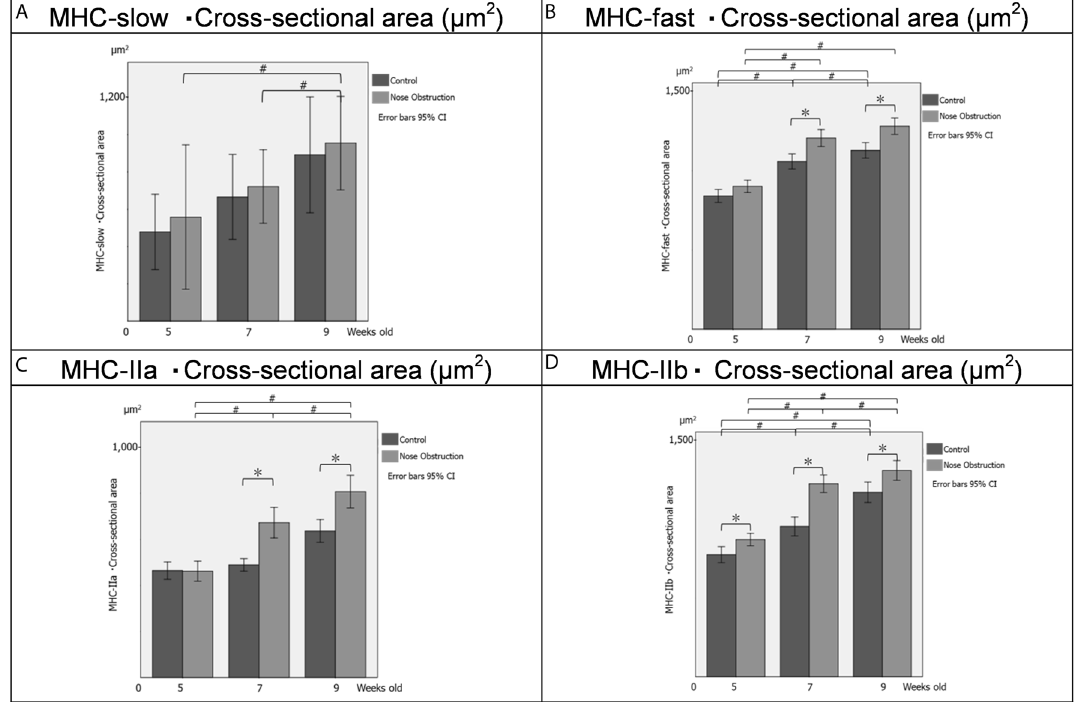
Figure 4. Cross-sectional area of the genioglossus muscle fibers. ( A ) Cross-sectional area of the slow-type muscle fibers at 5, 7 and 9 weeks old. ( B ) Cross-sectional area of the fast-type muscle fibers at 5, 7 and 9 weeks old. ( C ) Cross-sectional area of the fast IIa-type muscle fibers at 5, 7 and 9 weeks old. ( D ) Cross-sectional area of the fast IIb-type muscle fibers at 5, 7 and 9 weeks old. Bars in black, Control group; bars in grey, nose obstruction group. The x-axis shows the age of the rats, the y-axis shows the cross-sectional measurement of muscle fibers, for both control and nose obstruction groups. A repeated-measures multivariate analysis of variance was performed for intergroup and intragroup statistical comparisons. A simple main-effects analysis with Sidak adjustment was performed for multiple comparisons. Data are expressed as mean ± standard deviation. * ,# P < 0.05. Error bars at 95% confidence interval. MHC-slow Myosin heavy chain expression of slow- type muscle fiber, MHC-fast Myosin heavy chain expression of fast-type muscle fiber, MHC-IIa Myosin heavy chain expression of IIa fast-type muscle fiber, MHC-IIb Myosin heavy chain expression of IIb fast-type muscle fiber, 5 5 weeks-old, 7 7 weeks-old, 9 9 weeks-old, g grams, ms millisecond, %